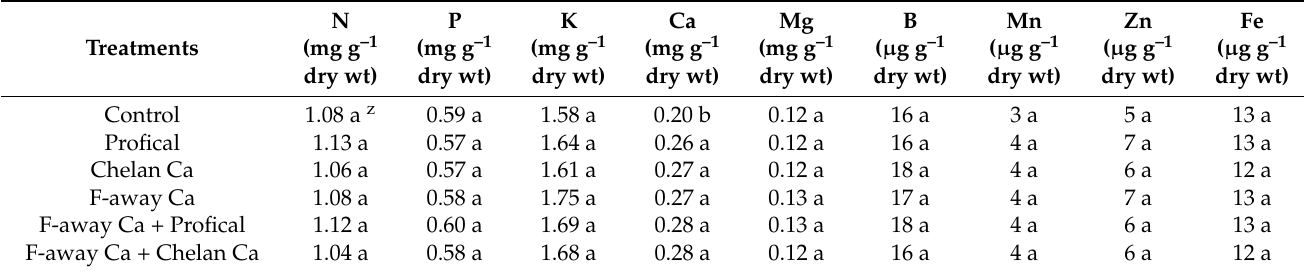
Table 6. Effect of foliar sprays on nitrogen (N), phosphorus (P), potassium (K), calcium (Ca), magnesium (Mg), boron (B), manganese (Mn), zinc (Zn) and iron (Fe) concentrations of the kiwifruit fruits (means of 2 years). N Treatments